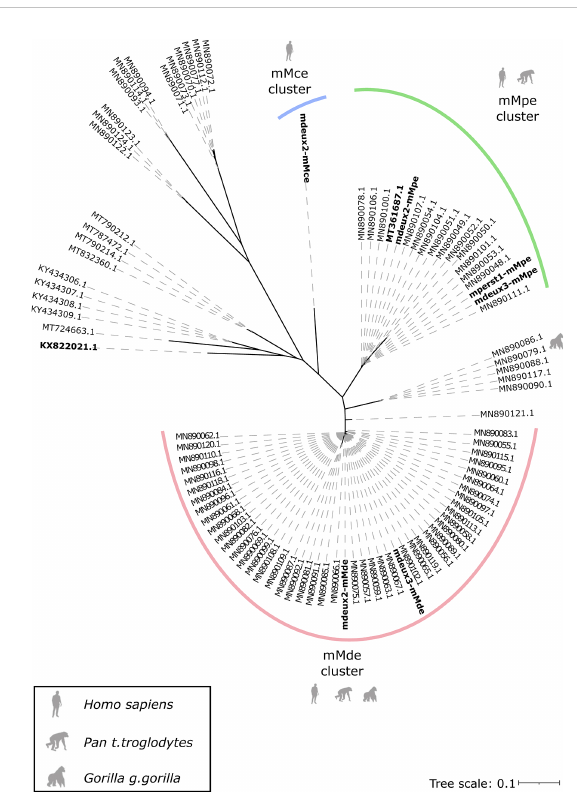
FIGURE 4 Phylogeny based on cox1 gene sequences. The three mitogenome clusters mMpe, mMde and mMce are highlighted in green, red and blue respectively. The generated mitogenomes, as well as the published mitogenomes from M. perstans (GenBank: MT361687) and M. ozzardi (GenBank: KX822021) are highlighted in